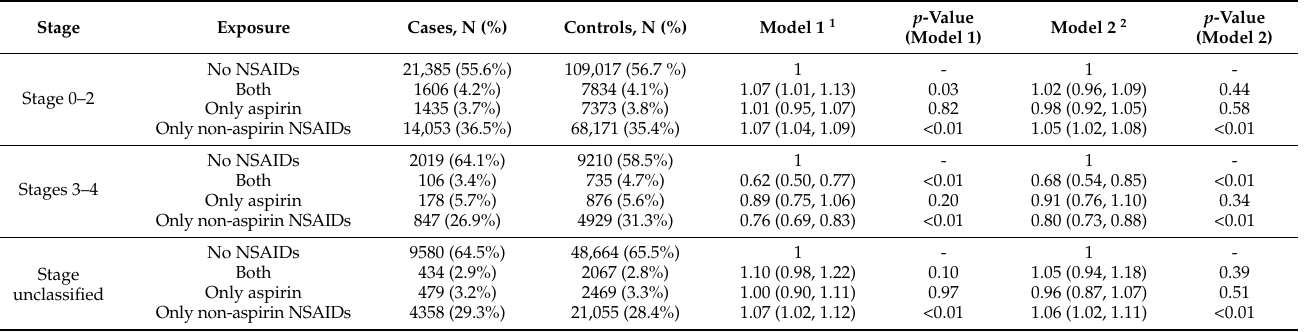
Table 3. Hazard ratios (95% confidence intervals) of breast cancer in relation to the nonexclusive use of NSAIDs; analysis by cancer stage in an analysis of the general female population in Sweden, 2006–2015.